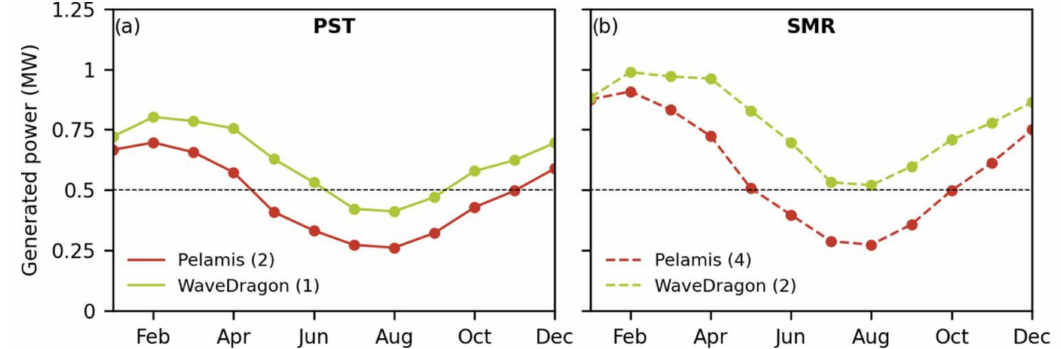
Figure 8. Monthly mean power extracted by WEC arrays at the PST ( a ) and SMR ( b ) sites, based on a DES. The number of devices used in each array is shown in parenthesis. The dashed line of 0.5 MW represents the generation capacity required to satisfy a